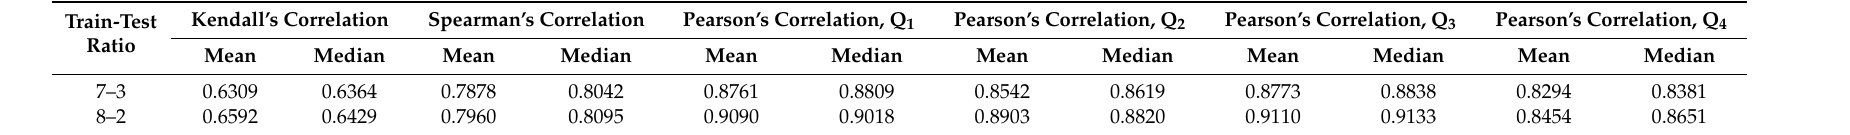
Table 1. Kendall’s, Spearman’s, and Pearson’s correlation for di ff erent train-test dataset ratio—SI H .